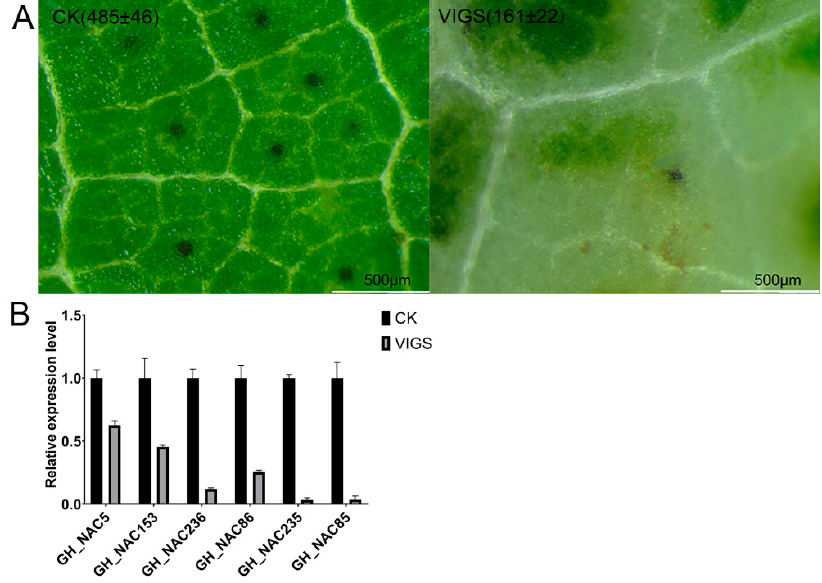
Figure 8. Silencing gland-related NAC genes causes reduction of gland number. ( A ) Microscopic images of VIGS plant leaf by stereomicroscope (Olympus SZX10). The number indicates gland number per cm 2 . ( B ) QRT-PCR analysis of genes expression in VIGS plants (reference gene: actin).